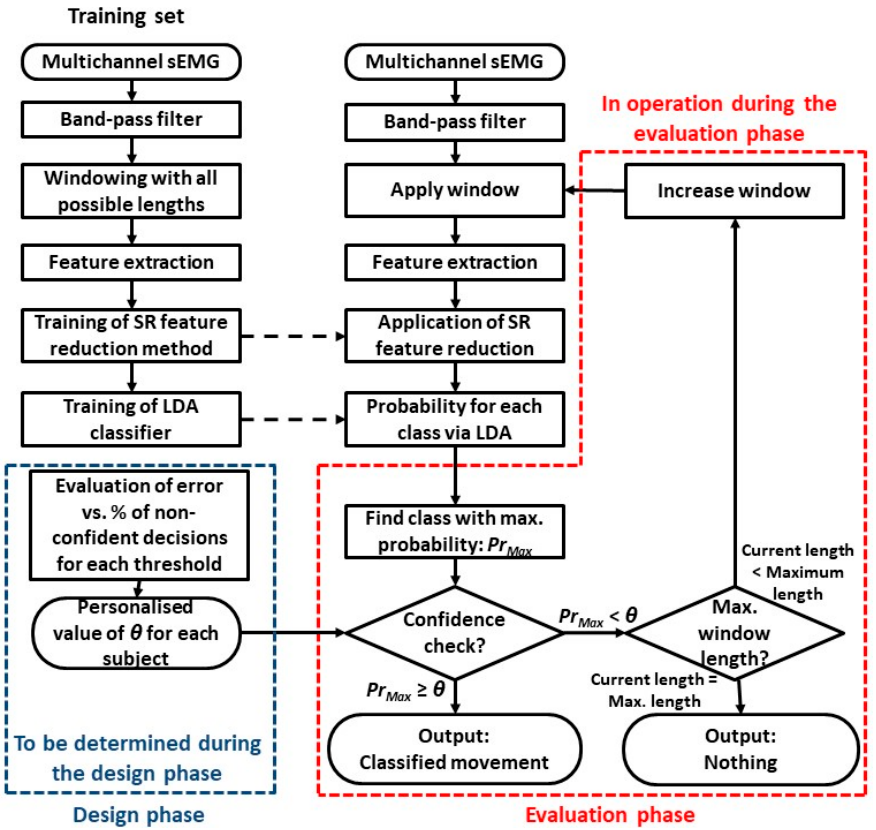
Figure 1. Block diagram of the proposed framework for adaptive windowing based on pattern recognition (PR).